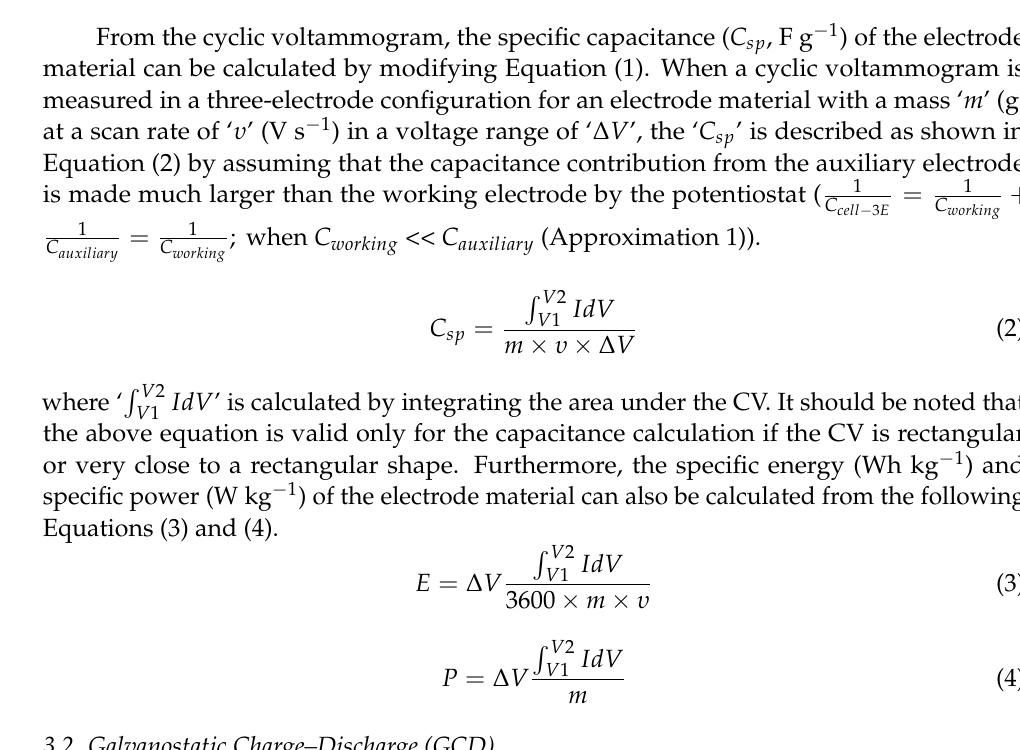
Figure 6. Typical ( a , b ) cyclic voltammograms, ( c ) discharge part of a galvanostatic charge-discharge (GCD), ( d ) Bode, ( e ) Nyquist plots, and ( f ) linear-sweep voltammogram.